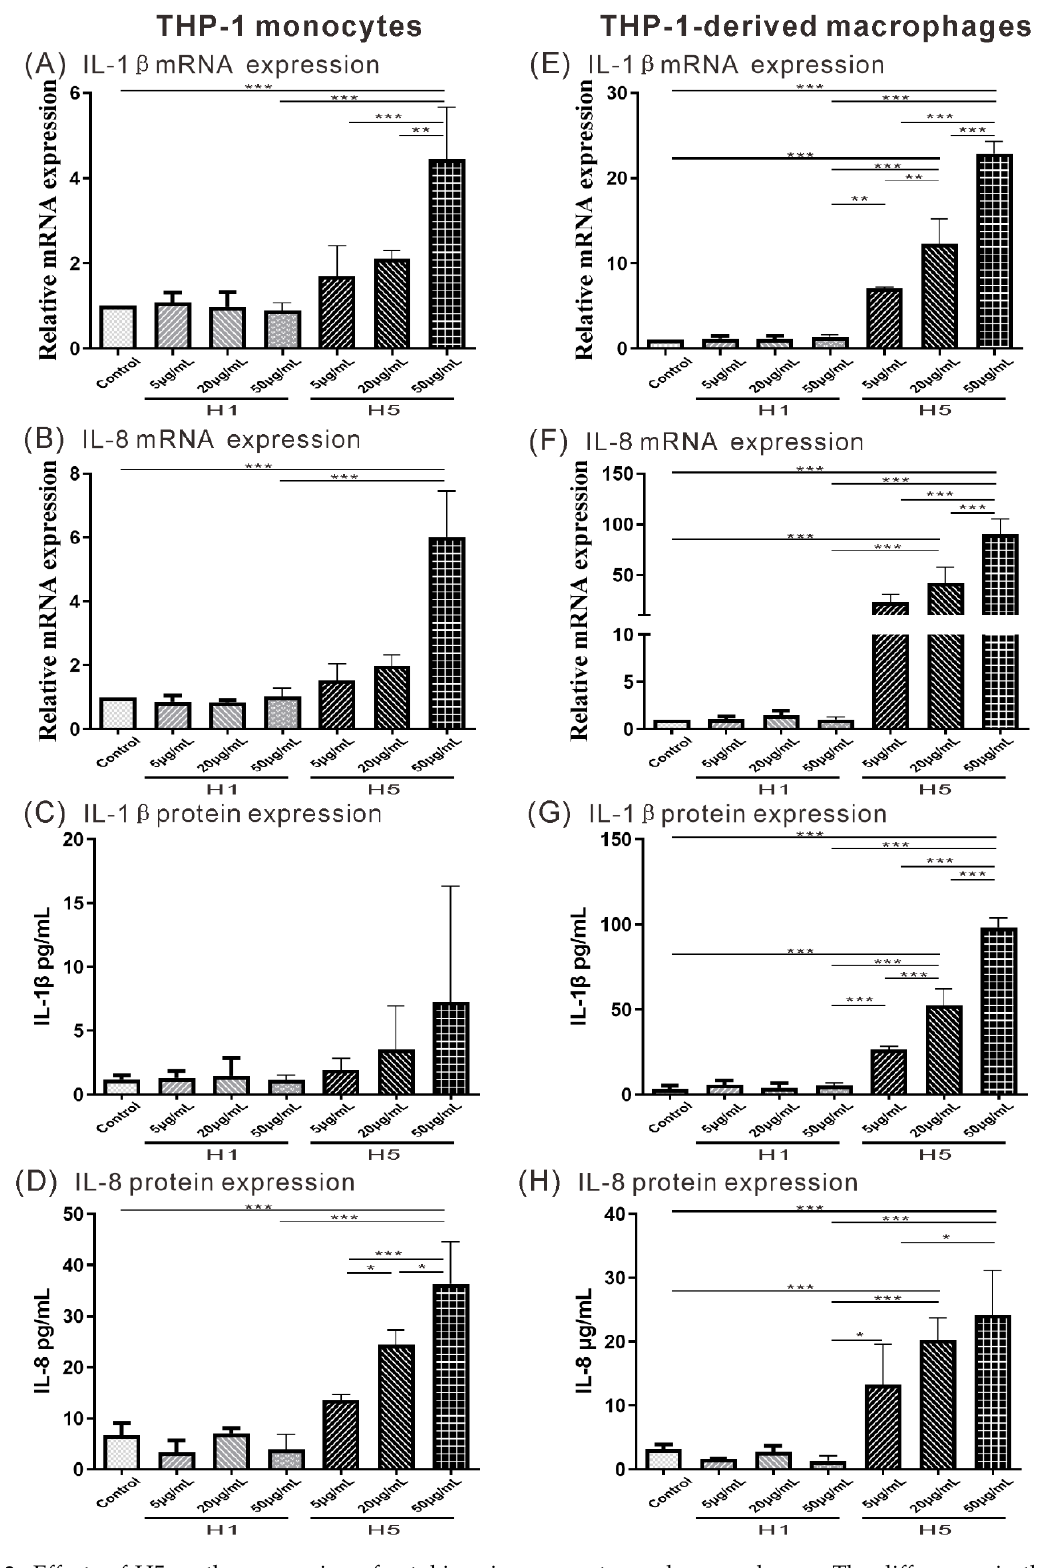
Figure 3. Effects of H5 on the expression of cytokines in monocytes and macrophages. The differences in the mRNA expression levels are shown for IL-1 β ( A , E ), IL-8 ( B , F ) in THP-1 monocyte and THP-1-derived macrophage. The differences in the protein levels are shown for IL-1 β ( C , G ), IL-8 ( D , H ) in THP-1 monocytes and THP-1-derived macrophages. * p < 0.05, ** p < 0.005, *** p < 0.001 determined by using one-way ANOVA test followed by Turkey’s post-test.